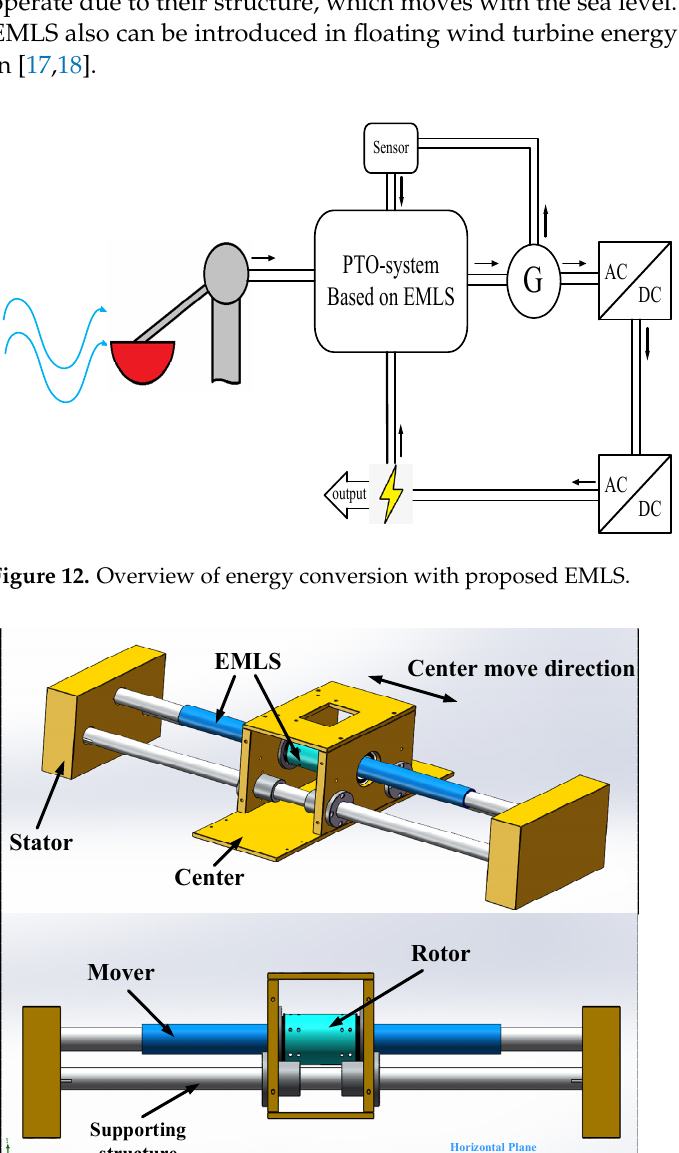
Figure 13. Structure of the improved PTO device.